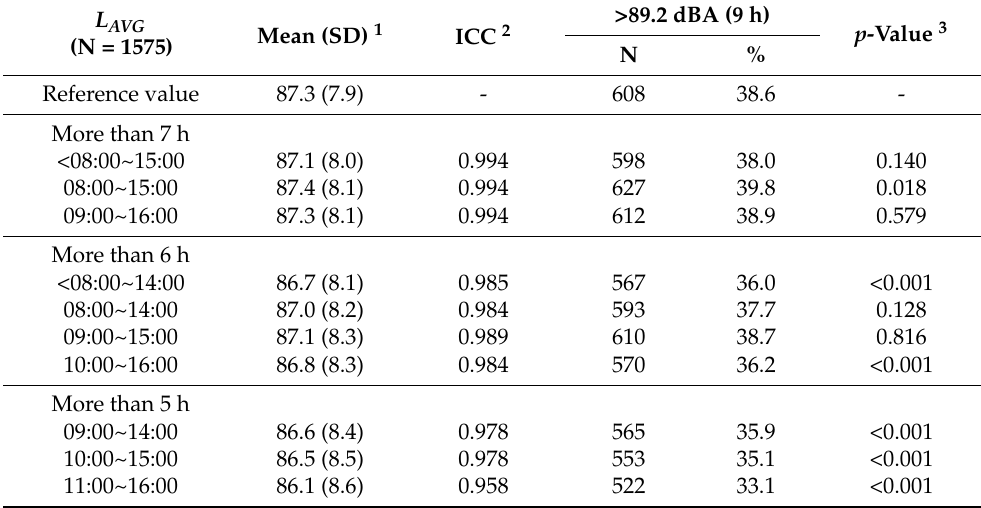
Table 8. The mean levels of occupational noise exposure compared with an exposure limit of 89.2 dBA (9 h), including break period, by increasing an hour in different monitoring schedules. L AVG (N =